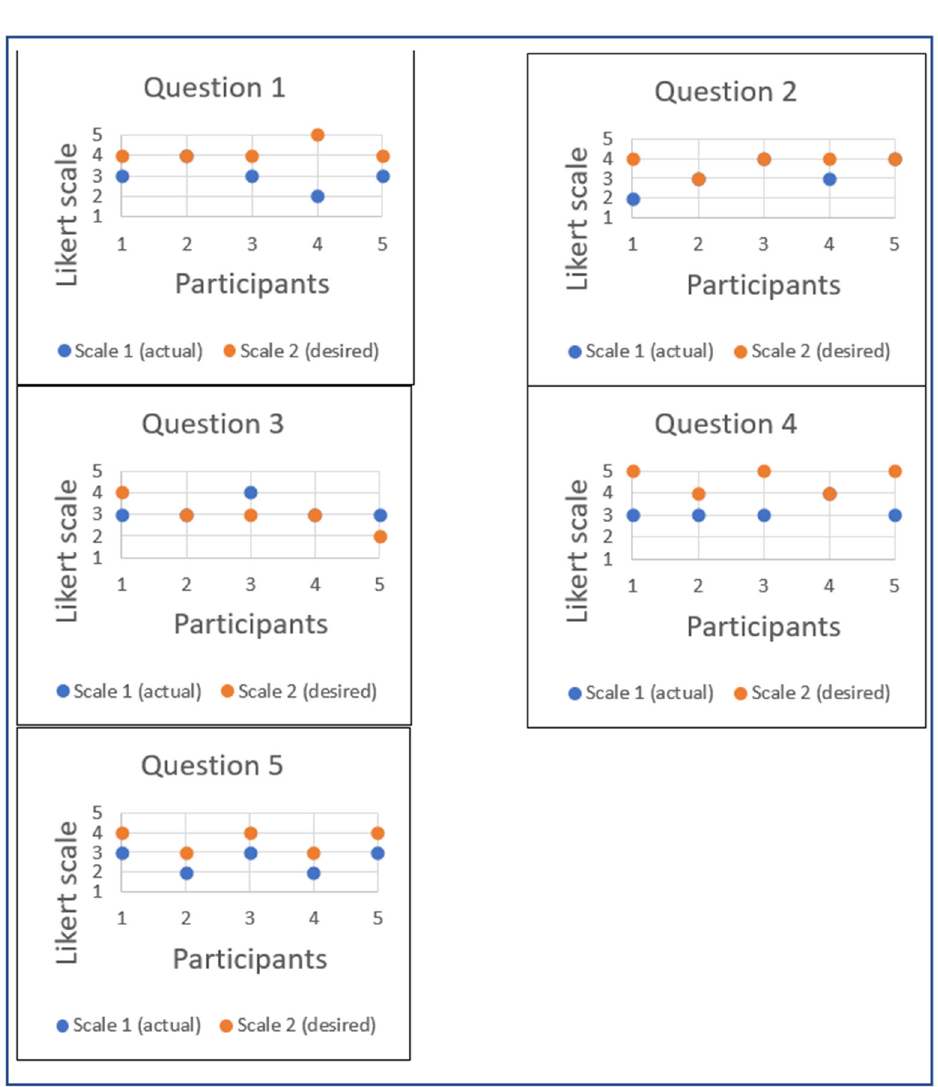
Figure A1. Scatter plots of the five questions asked to participants, described in Table 2.